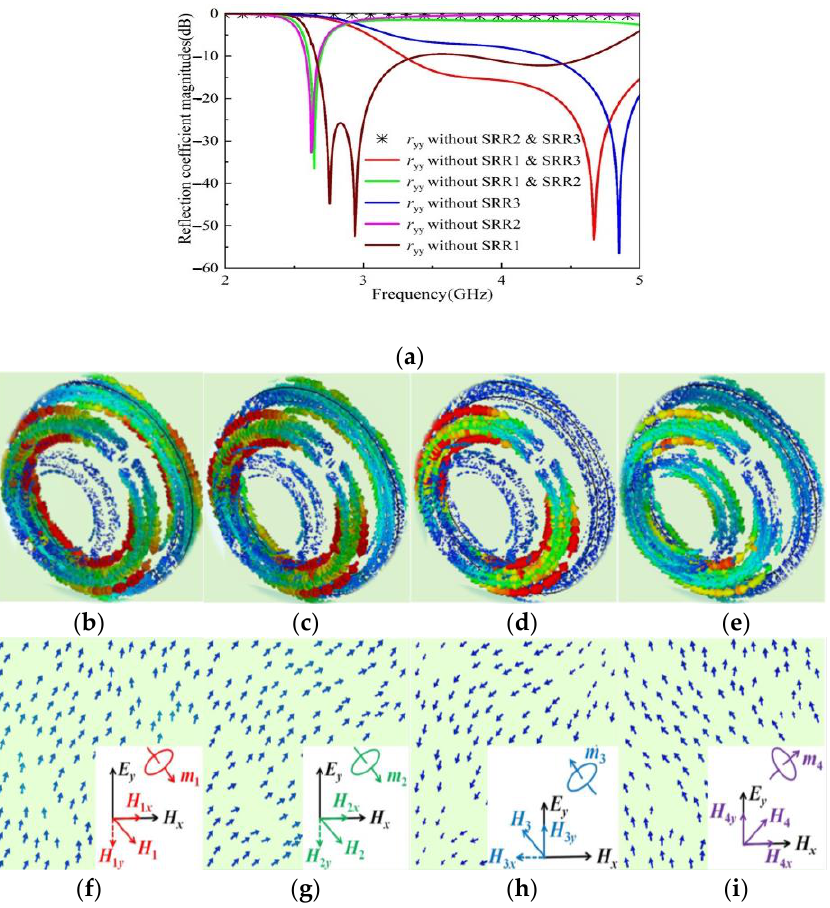
Figure 3. Co-polarization reflection coefficient amplitudes and the surface current distributions on SRRs and ground. ( a ) Co-polarization reflection coefficient amplitudes. 3D SRRs surface current distributions at ( b ) 2.78 GHz, ( c ) 3.09 GHz, ( d ) 3.68 GHz, and ( e ) 4.54 GHz. 2D ground surface current distributions at ( f ) 2.78 GHz, ( g ) 3.09 GHz, ( h ) 3.68 GHz, and ( i ) 4.54 GHz.